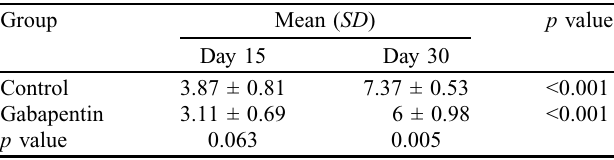
Table 2. Comparison of histological scores between the control and treatment